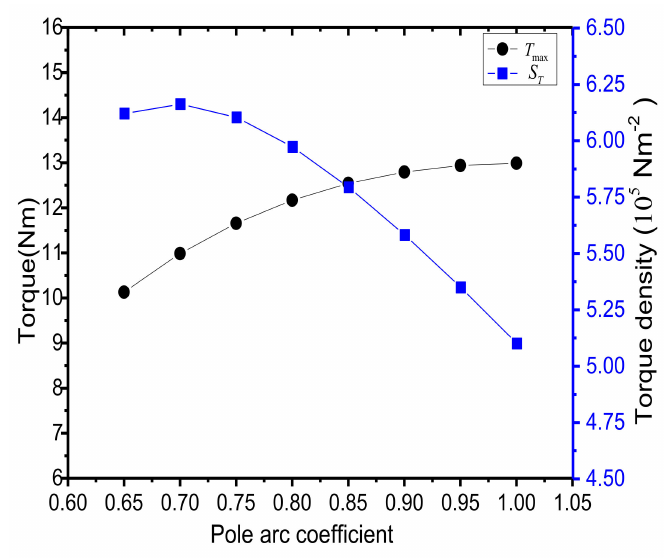
Figure 13. T max and S T versus pole arc coe ffi cient.